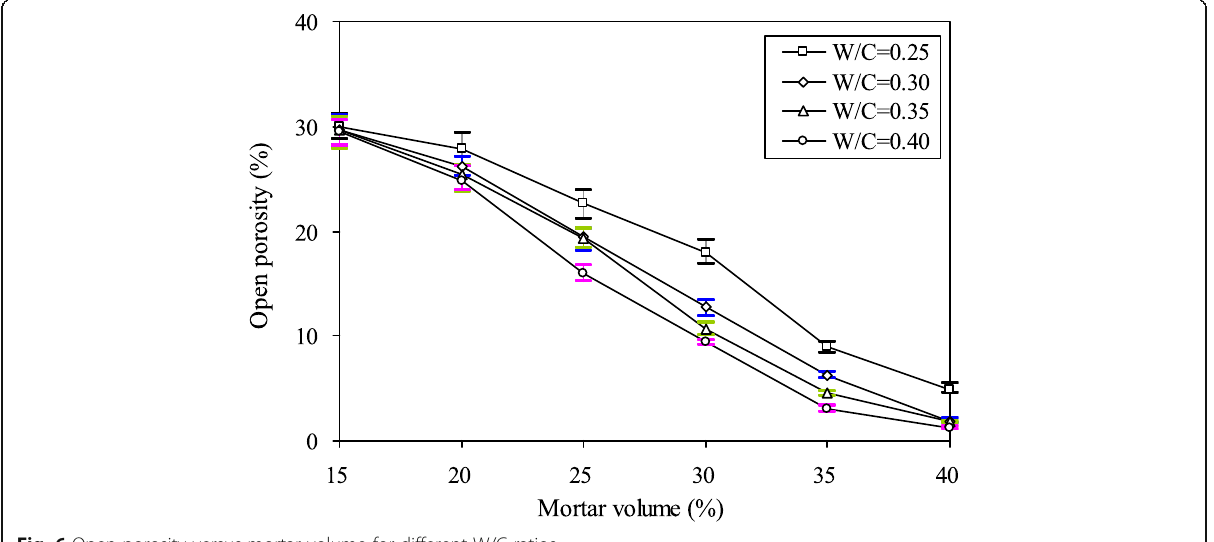
Fig. 6 Open porosity versus mortar volume for different W/C ratios